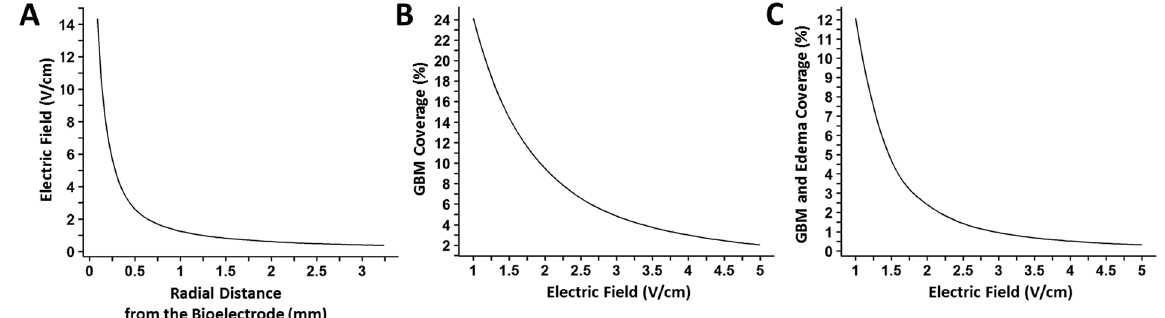
Figure 7. Predicted relations between IMT electric field amplitude, radial field dimensions and extent of GBM region coverage in the present in vivo treatment